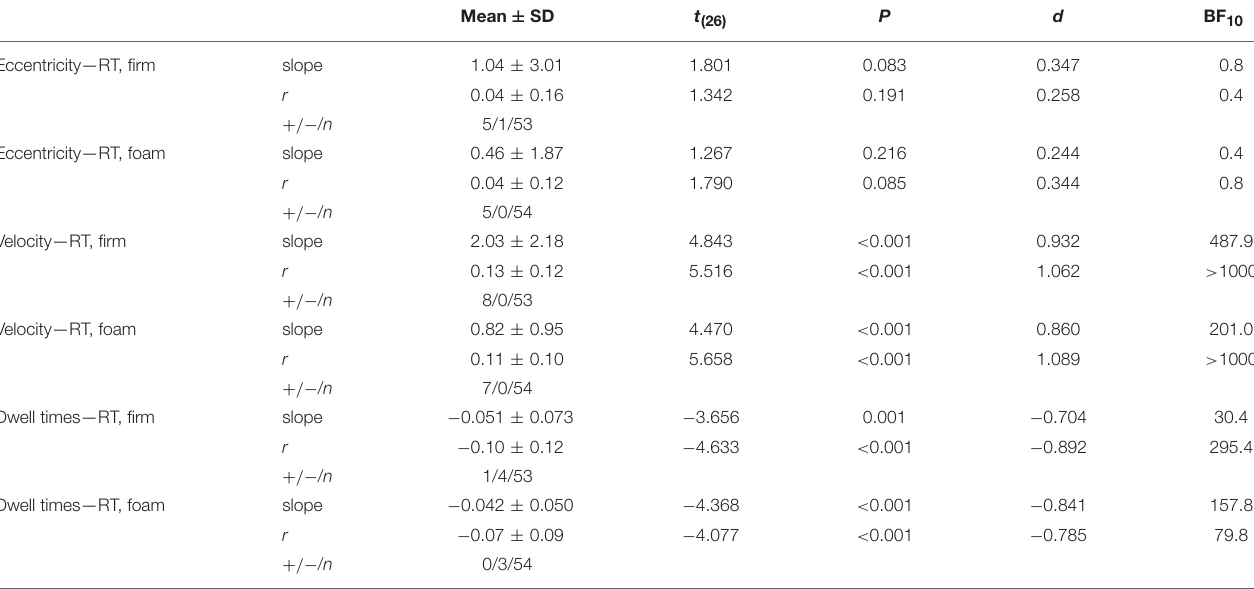
TABLE 2 | Mean slopes (slope), Pearson correlation coefficients (r), and their standard deviations (SD) as well as the number of significant positive ( + ) and negative (–) correlations of all trials n between the three local posturographic outcomes and reaction times (RT), separately for firm and foam